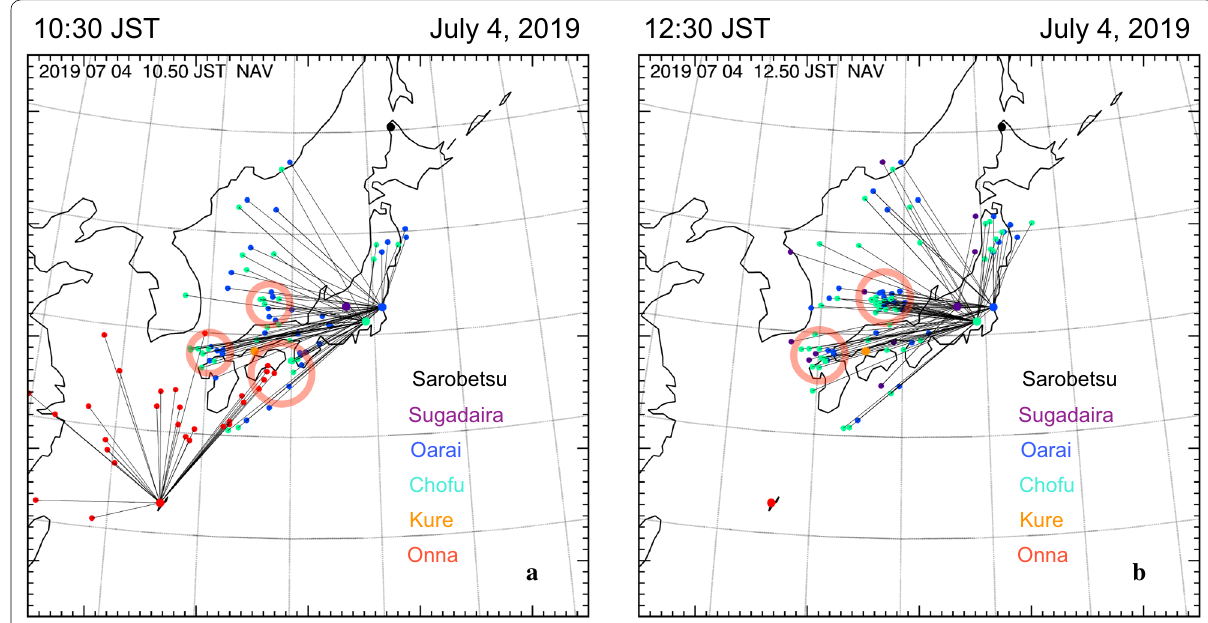
Fig. 6 Distribution of mid-points of Tx and Rx stations for all the detected anomalous propagation at 10:30 JST ( a ) and 12:30 JST ( b ) on July 4,